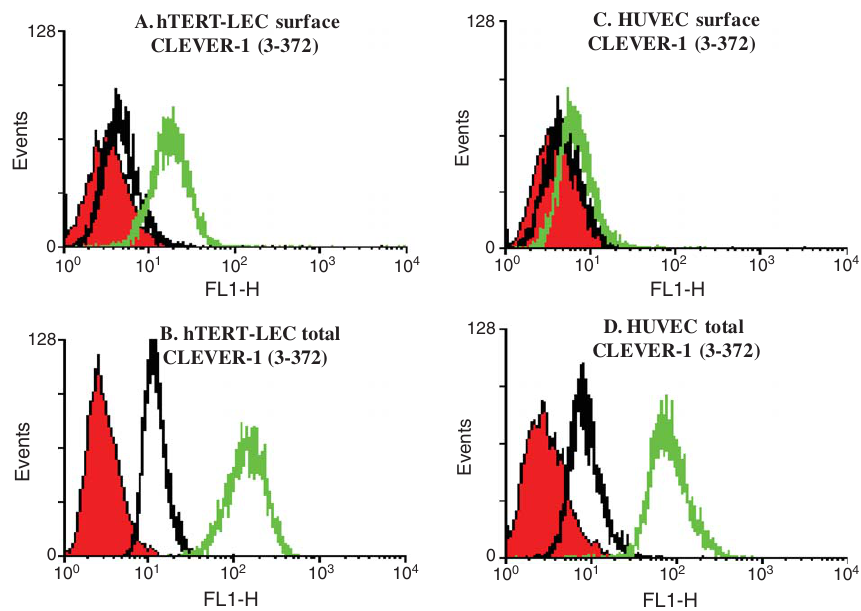
Fig. 1. Representative cytoflorograms of surface (A and C) and intracellular (B and D) staining of CLEVER-1 expression in hTERT-LEC (A and B) and HUVEC (C and D). Both EC express CLEVER-1 however surface expression is higher on hTERT-LEC. Red (solid) areas represent untreated cells, black line is the IgG1 isocontrol and green (grey) represents CLEVER-1 expression as detected via 3-372 antibody